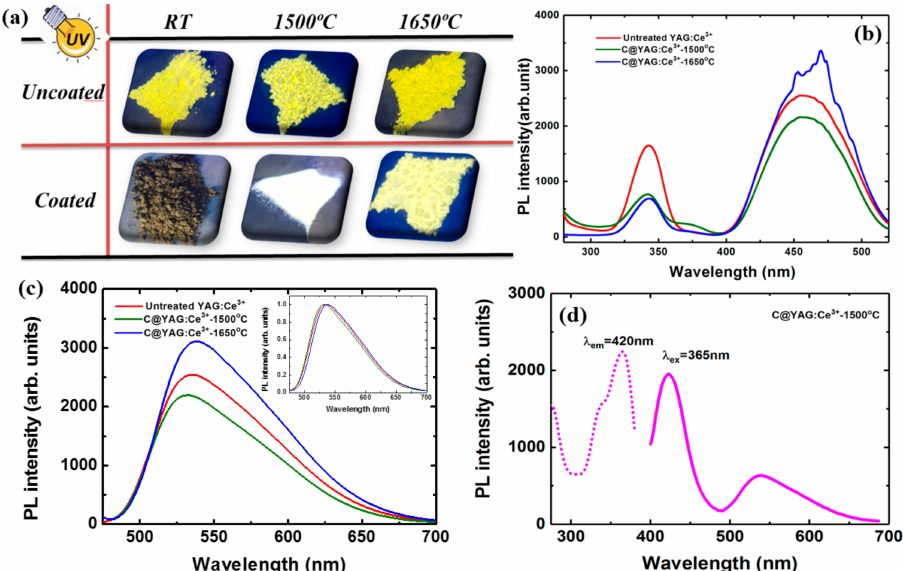
Figure 3. ( a ) Pictures of uncoated and C-coated YAG:Ce 3+ samples under UV-365 nm light after heat-treatment at different temperature; ( b ) photoluminescence excitation (PLE) spectra recorded at 540 nm and ( c ) PL spectra under 460 nm excitation for untreated YAG:Ce 3+ , C@YAG:Ce 3+ -1500 ◦ C